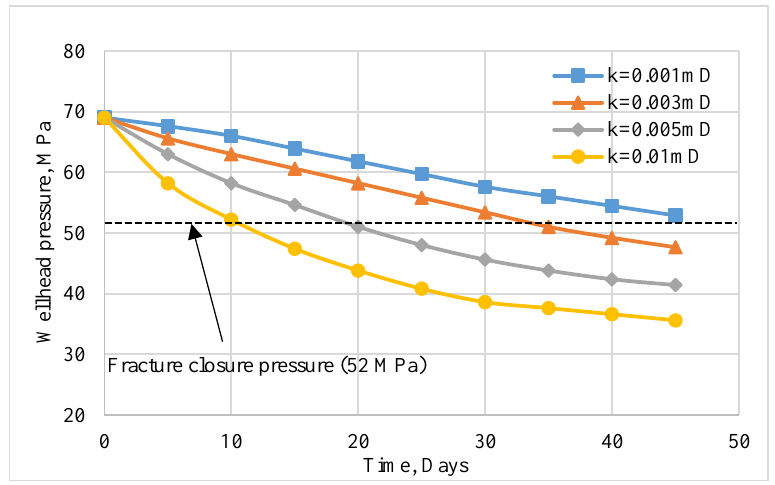
Figure 10—Wellhead pressure in the fracture with various matrix permeabilities.